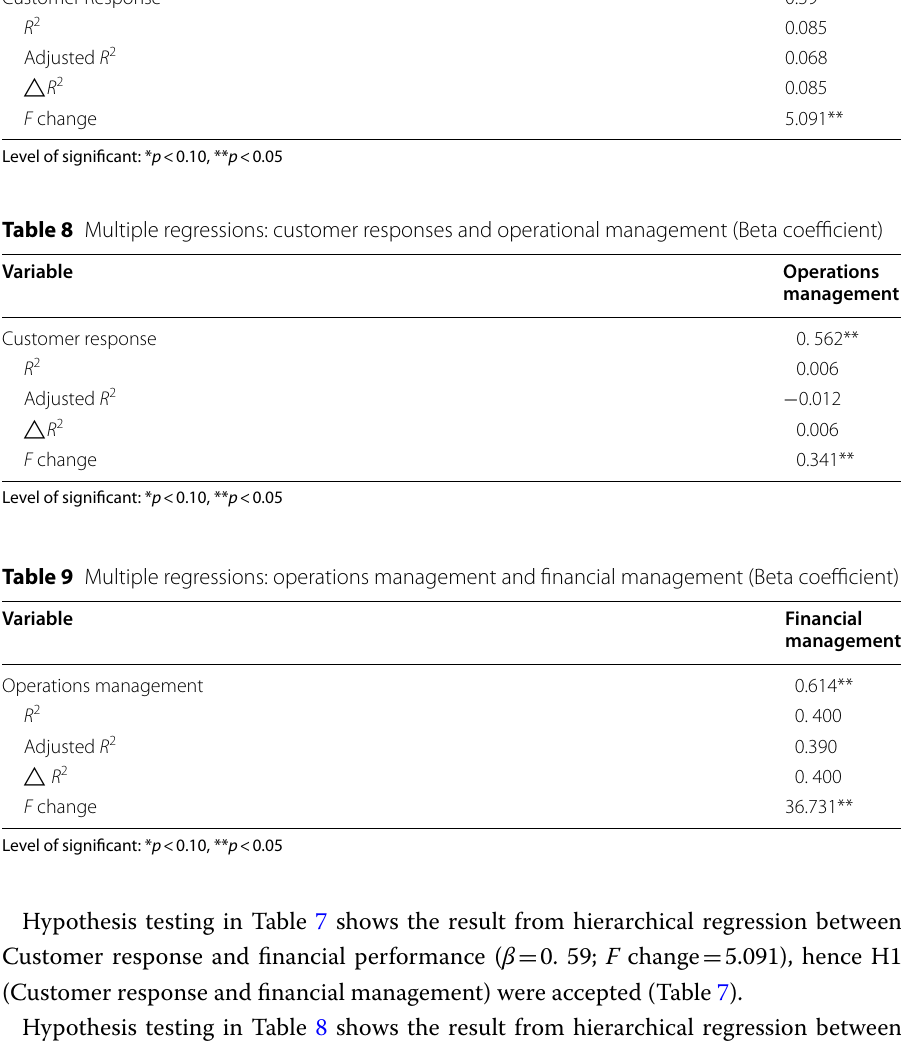
Table 7 Multiple regressions: customer responses and financial management (Beta coefficient)